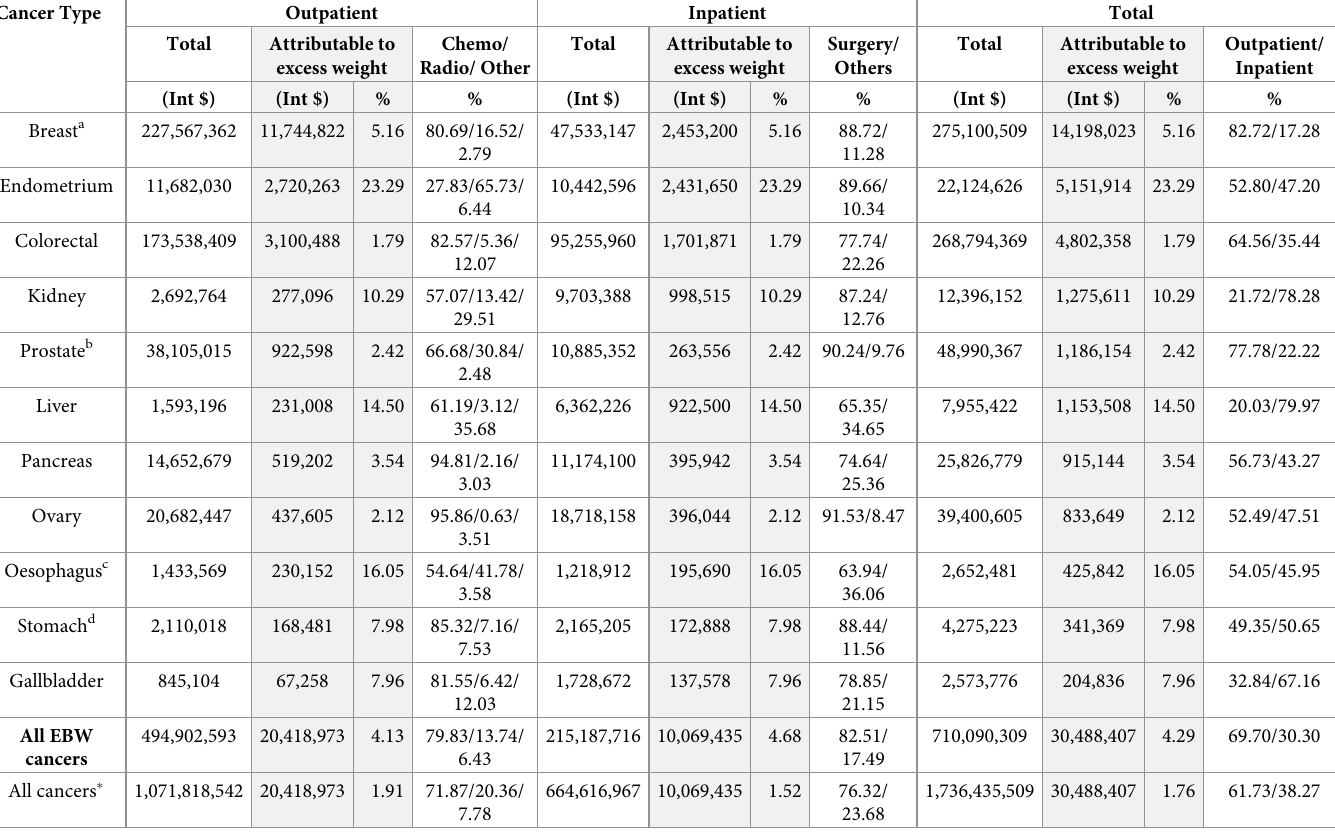
Table 2. Federal costs of cancers attributable to excess body weight according to type of medical care. Brazil,